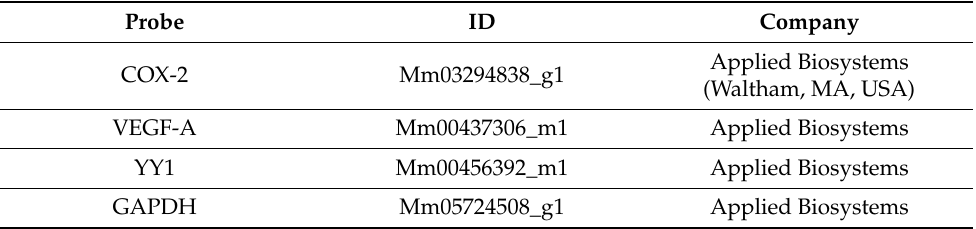
Table 5. Probes used for mRNA detection by